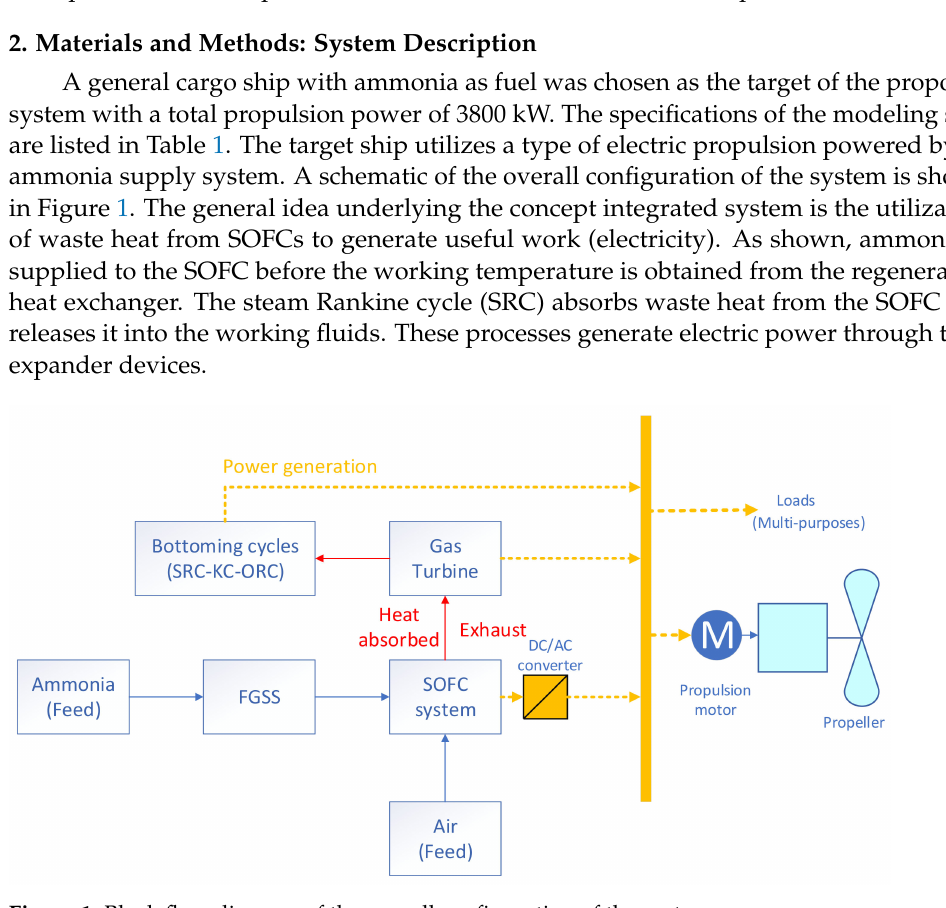
Figure 1. Block flow diagram of the overall configuration of the